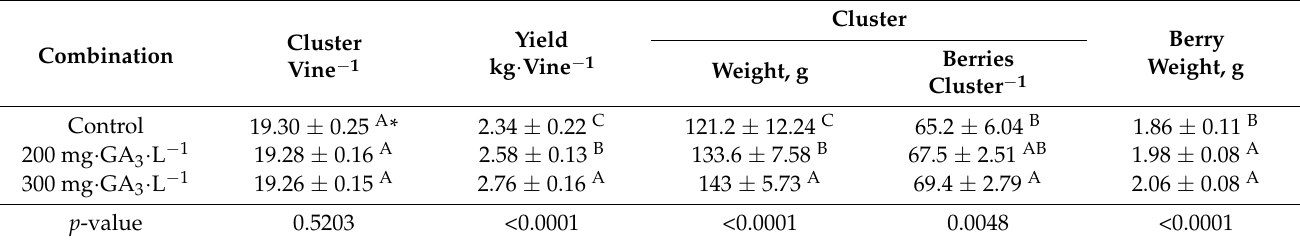
Table 1. Effect of gibberellic acid on the size yield of ‘Einset Seedless’ grapevine.